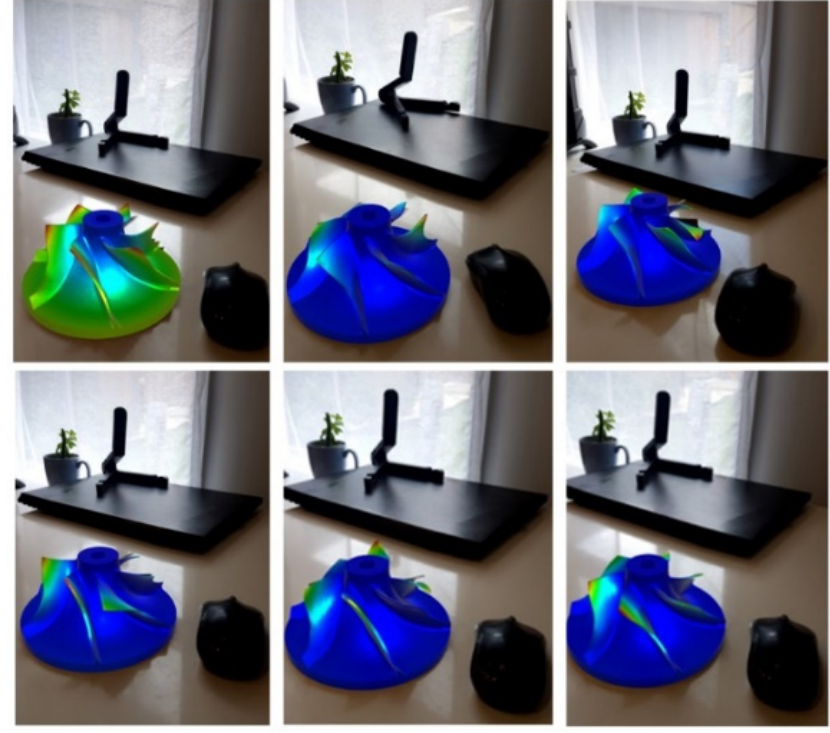
Figure 10. Modal analysis simulation results for modes 1 to 6 on the mobile AR visualization. FEA Visualization AR-Overlay on Real Part